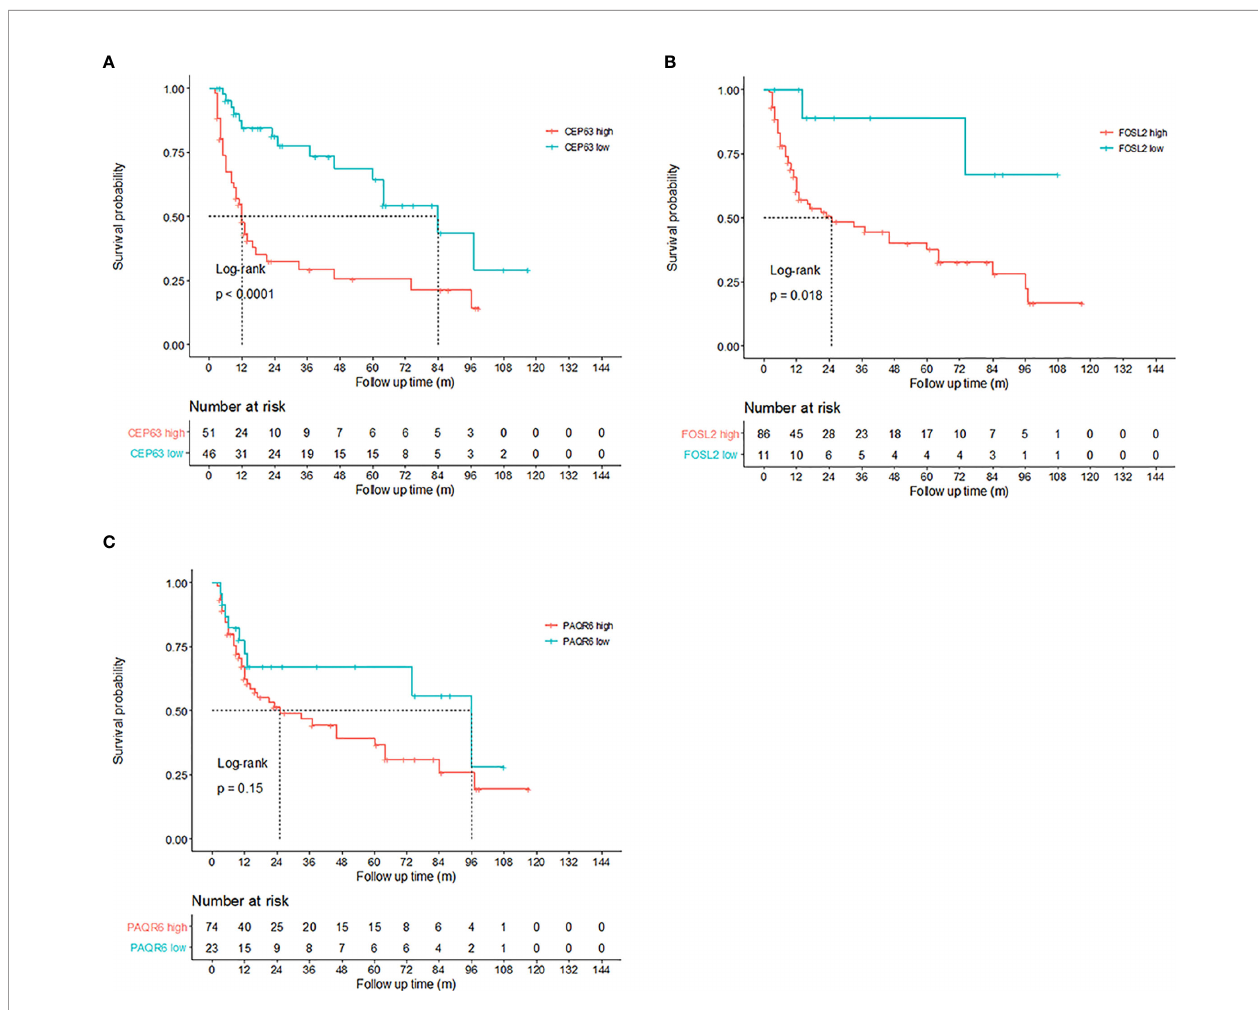
FIGURE 6 | Prognosis prediction by 3 identi fi ed genes in urine sediment samples detected by real-time polymerase chain reaction (PCR). Kaplan-Meier curves showed that copy numbers gains of (A) CEP63 and (B) FOSL2 were associated with poor disease-free survival (DFS) in non-muscle-invasive bladder cancer (NMIBC) patients (p<0.0001 and p=0.018, respectively). The cutoff point of the copy number ratio relative to the TATA-box binding protein (TBP) gene for CEP63 and FOSL2 was 1.02 and 0.97, respectively. No correlations were found between DFS and CNVs of (C)